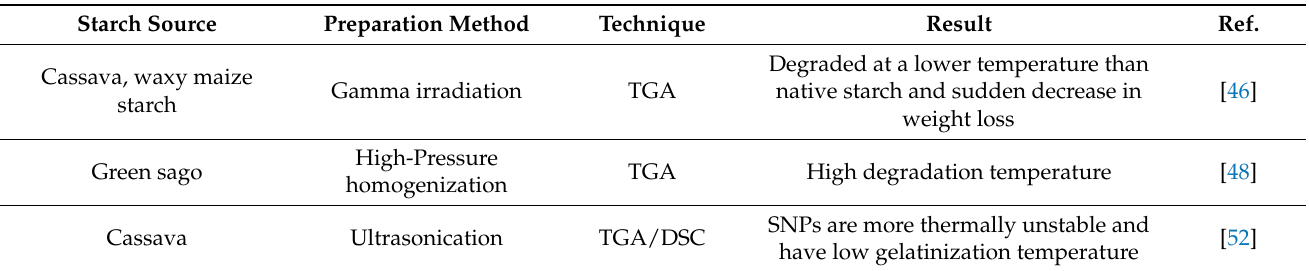
Table 4. Thermal characteristics of starch